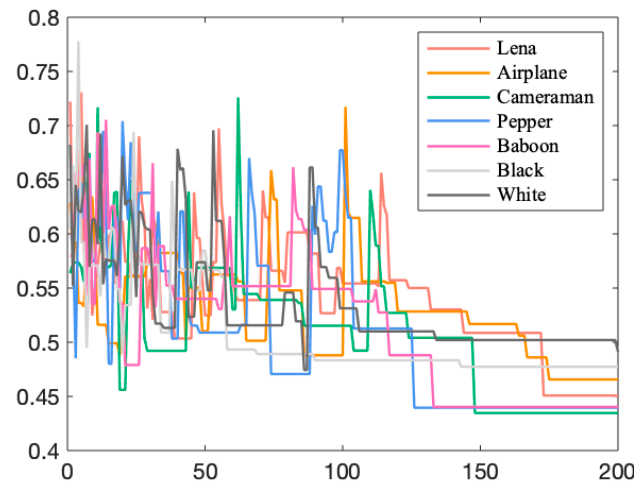
Figure 6. Image annealing process.